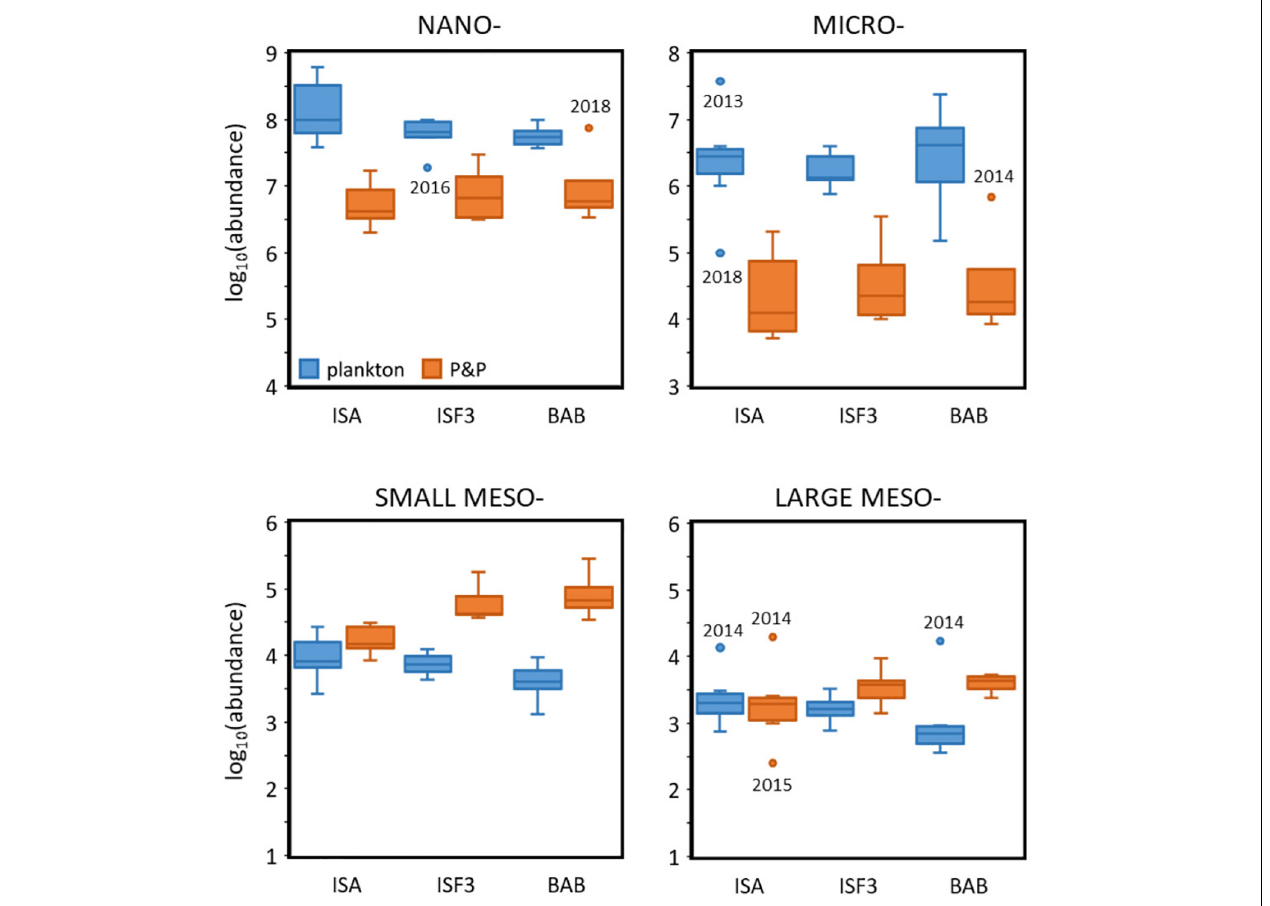
FIGURE 7 | Log-transformed abundances (individuals · m − 3 and counts · m − 3 ) of plankton (blue) and P&P (orange) within four analyzed size fractions at three Isfjorden stations: ISA, ISF3 and BAB in seven consecutive mid-summers (2013–2019). The start (the lower quartile) and the end of the box (the upper quartile) represent 25% and 75% of the data, respectively. The line in the box represents the median value. The whiskers are defined as 1.5 times the inter-quartile range. Anything outside the whiskers is considered as an outlier